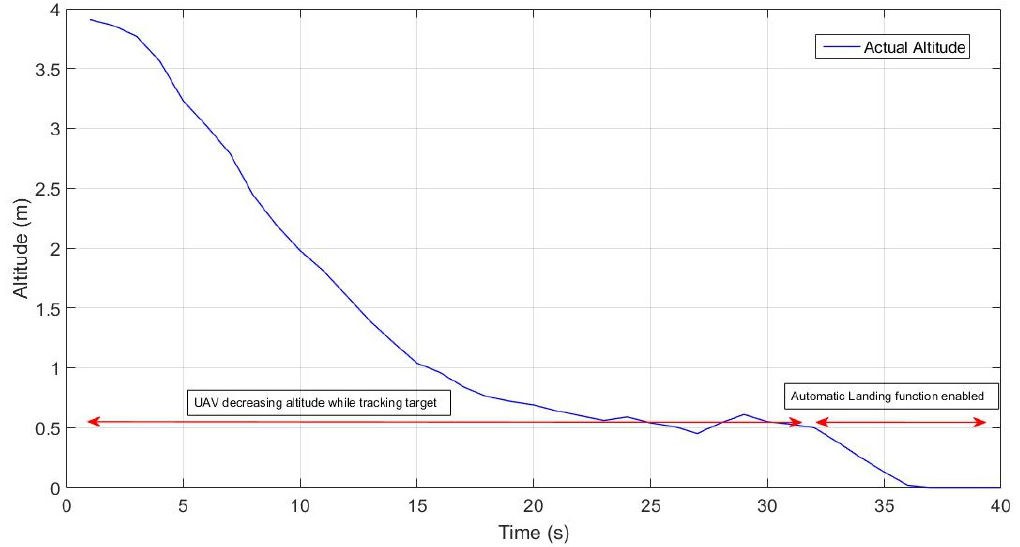
Figure 12. Unmanned aerial vehicle decreasing altitude while tracking and